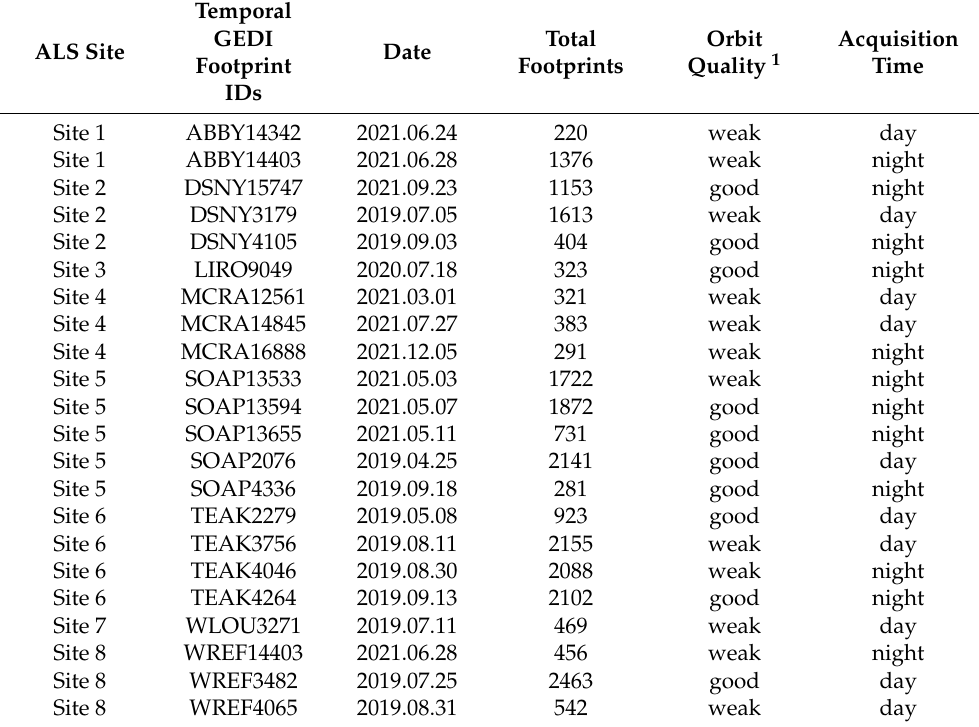
Table 2. Multi-temporal GEDI footprints with related